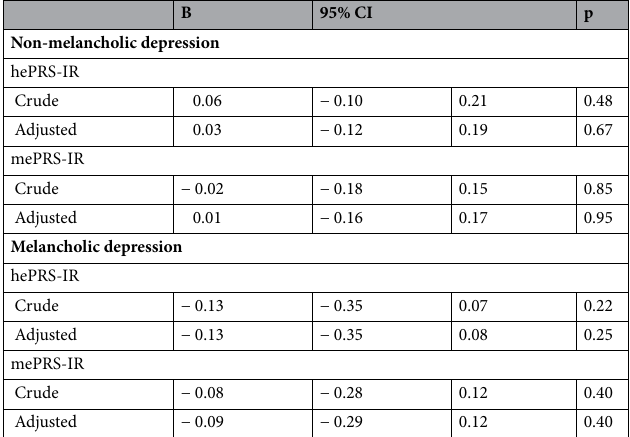
Table 5. The association between the biologically informed polygenic risk score for insulin receptor (ePRS-IR) and non-melancholic and melancholic depression with ePRS-IR as continuous variable. Model 1 = adjusted for age, sex and population stratification. Model 2 = adjusted for Model 1 + smoking, alcohol usage, socioeconomic class, body mass index, leisure-time physical activity and comorbidities. hePRS-IR hippocampal biologically informed polygenic risk score for insulin receptor, mePRS-IR mesocorticolimbic biologically informed polygenic risk score for insulin receptor, B regression coefficient. P values were based on the bootstrap style method of 1500